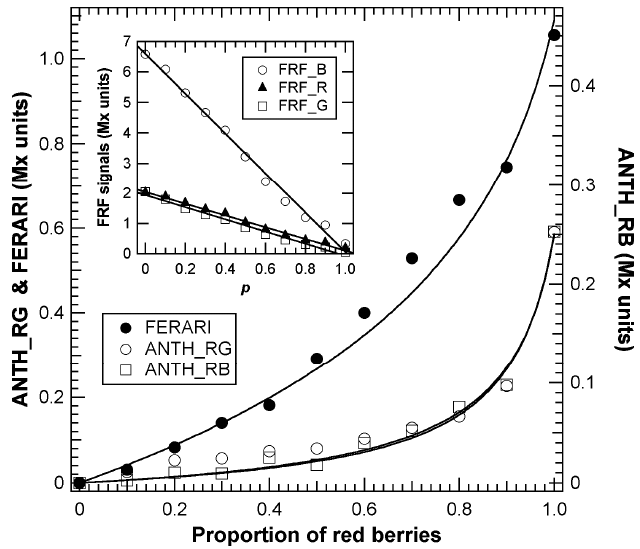
Figure 8. Multiplex ® signals and indices as a function of the proportion of red berries ( P -model). Linear fit for the three FRF signals are shown, all r² = 0.99. ANTH_RG and ANTH_RB indices where normalised by subtracting the constant log(  respectively. For the fits of ANTH indices, see